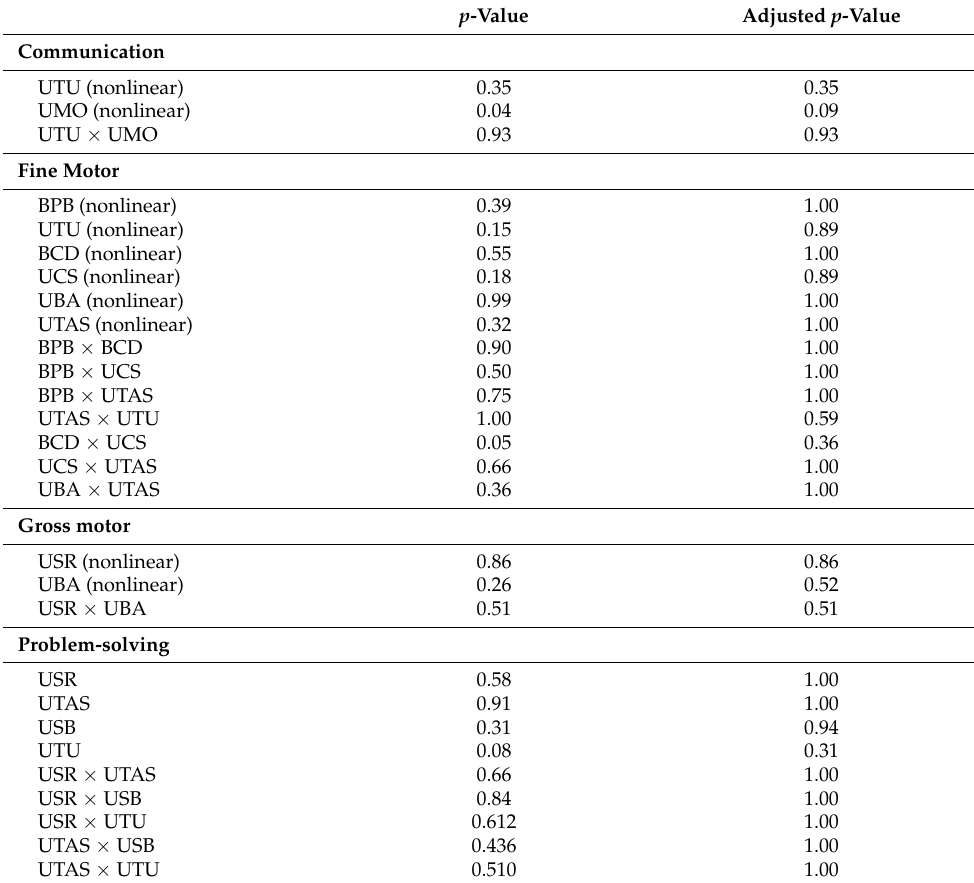
Table A2. List of p -values with multiple comparison adjustments for testing the non-linear and interaction effects of metals on ASQ. p